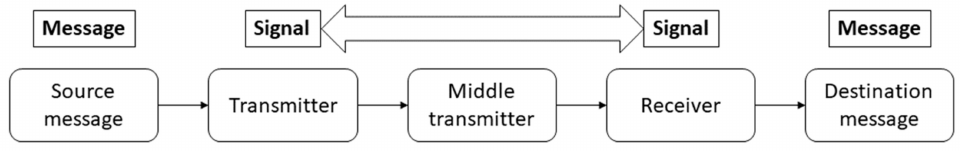
Figure 3. Rules for establishing communication.